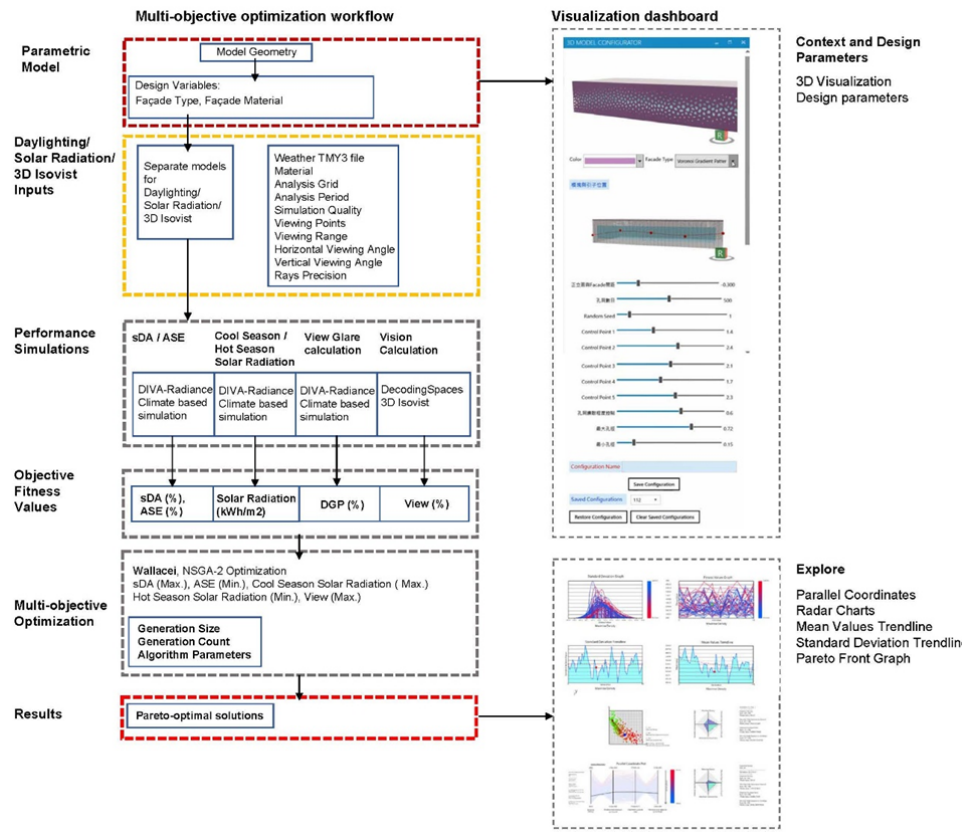
Figure 1. The BPO framework for a building façade design.